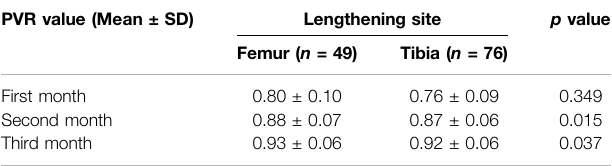
TABLE 5 | Subgroup analysis for the early PVR based on the lengthening